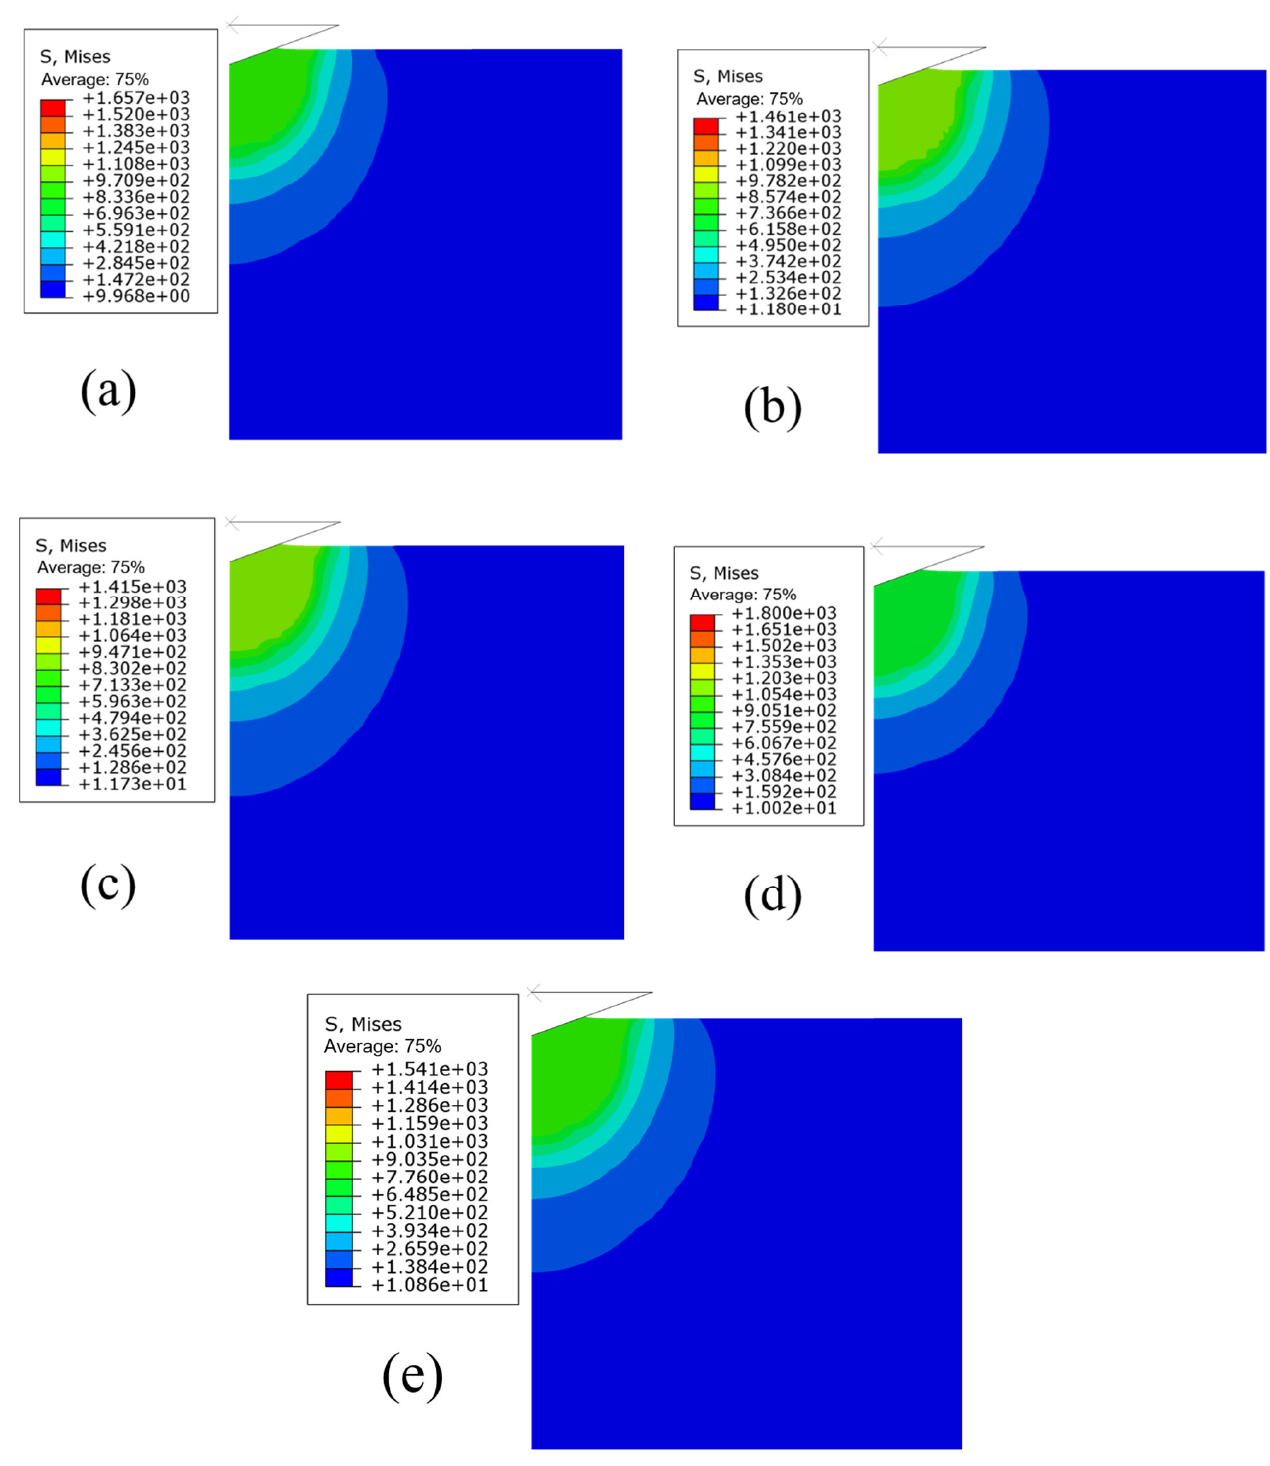
Figure 7. Stress distributions: ( a ) convex defect; ( b ) groove defect; ( c ) tip bluntness; ( d ) tip sharpness; ( e ) plane.